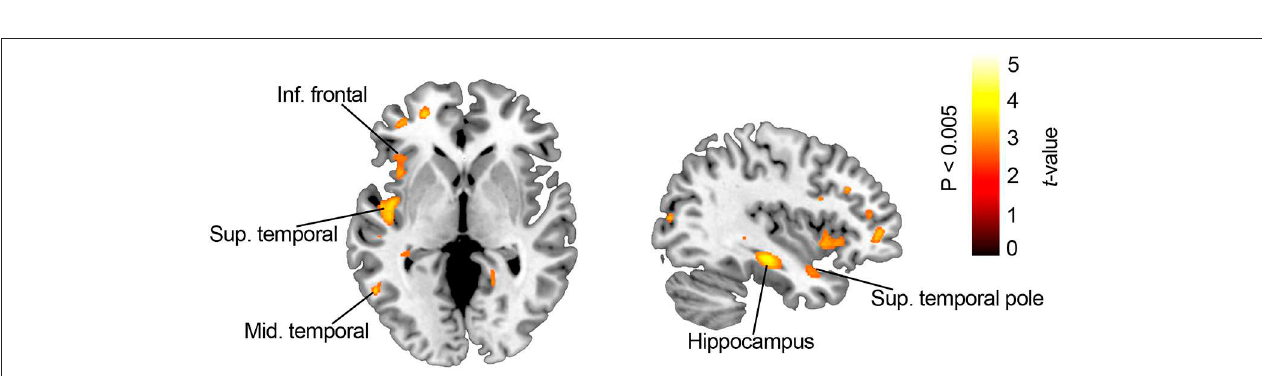
FIGURE 2 | Results of the VBM analysis. The slices show regions with significant GMV decreases in association with poorer FCSRT performance. Section (A) (top) depicts GMV associated with DFR performance; section (B) (bottom) depicts GMV associated with DTR performance. For depiction purposes results are showed with a p < 0.005 (uncorrected) and k = 100.